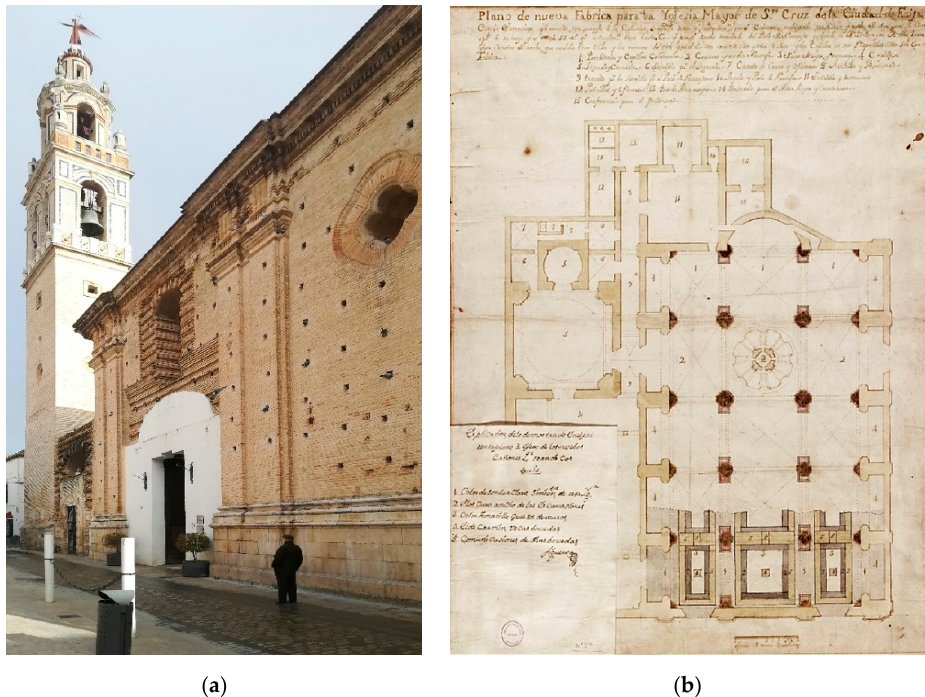
Figure 2. ( a ) Current façade of the church; ( b ) original plan of the Santa Cruz church [61].